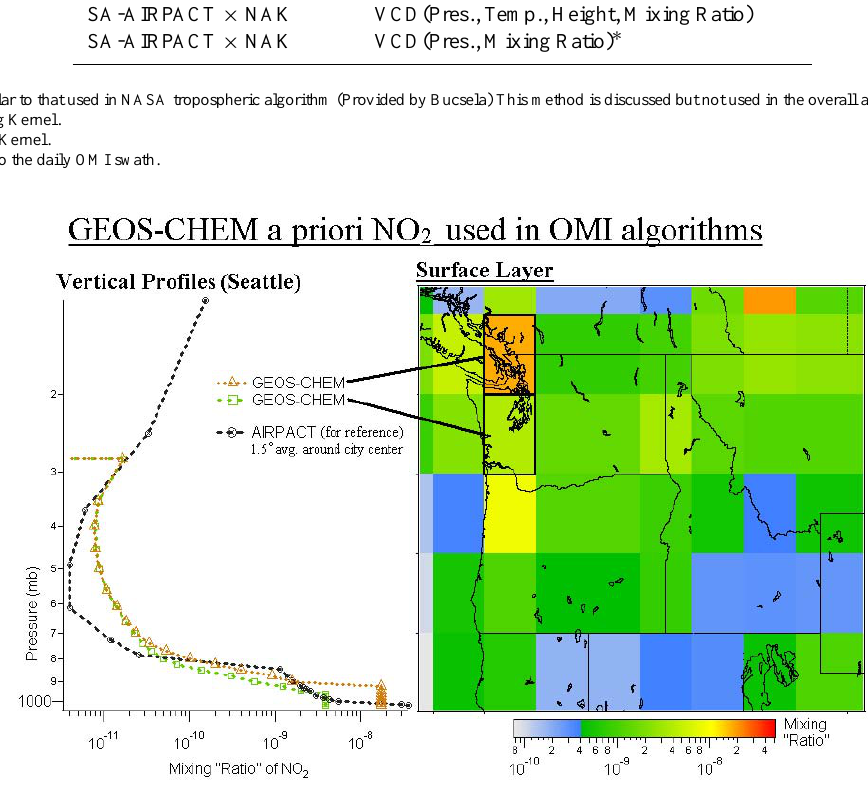
Fig. 3. A priori NO 2 used in OMI NASA algorithms, developed by Randall Martin with GEOS-CHEM simulations. The grid below is a 2 ◦ × 2 ◦ matrix used for the OMI (NASA) algorithm, regridded from the original GEOS-CHEM simulations with original resolution of 2 ◦ × 2.5 ◦ . Note the profiles shown for two pixels over the Seattle metro area; these profiles show nearly an order of magnitude difference at the surface